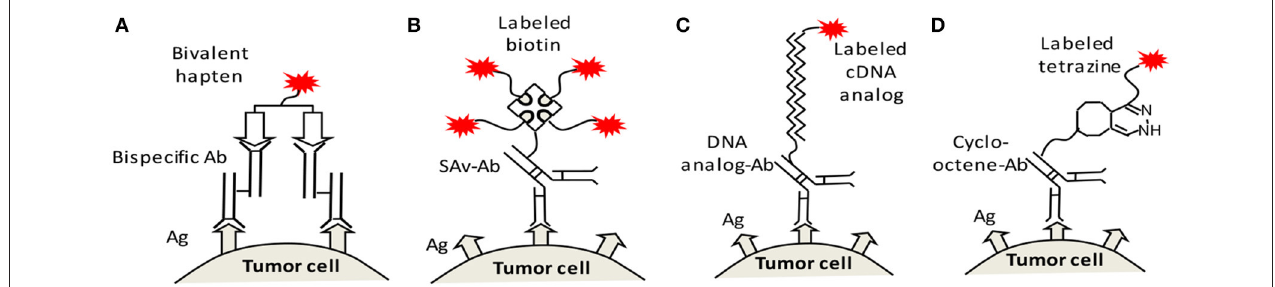
FIGURE 2 | Four recognition mechanisms for pretargeting, namely (A) bispecific antibody/bivalent hapten, (B) streptavidin (SAv)/biotin, (C) DNA/cDNA analogs, and (D) in vivo clicking reaction (shown as an example is the reaction between cycloctene and tetrazine). Ag, antigen; Ab, antibody; SAv,